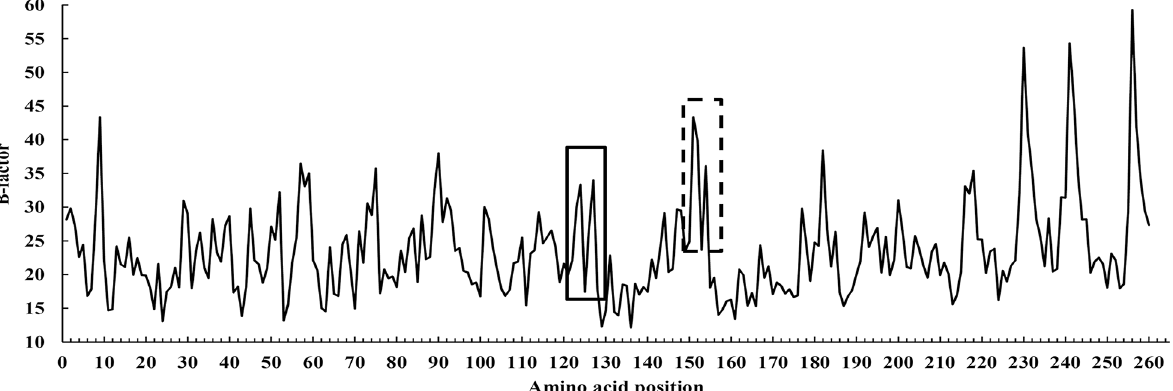
Fig 8. The B-factor values of amino acid residues of AnFaeA (PDB code: 1USW). The regions around amino acid residues 126 and 152 with high B- factor values are marked in solid and dashed boxes.